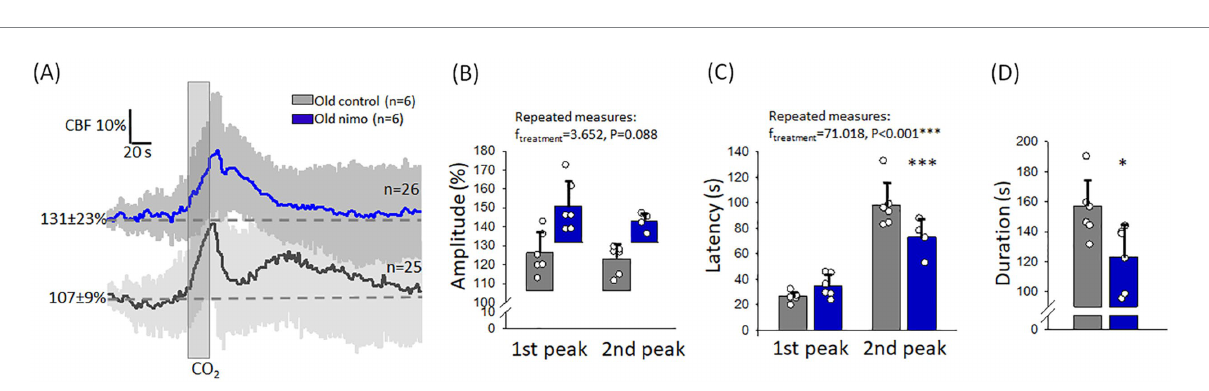
FIGURE 6 The impact of nimodipine treatment on the hyperemic response to hypercapnia in old animals. (A) Mean traces (±stdev) of the CBF response to hypercapnia in the Old control and nimodipine-treated Old nimo groups. (B) The amplitude of hyperemia. Note that the bars showing the relative amplitude are positioned on the CBF value preceding hypercapnia, to reflect the absolute amplitude of the CBF response. (C) The latency of the peak of hyperemia with respect to the onset of hypercapnia. (D) The duration of hyperemia. In B-D , data are given as mean ± stdev. The normal distribution of data was evaluated with a Shapiro–Wilk test ( B : p = 0.124-failed, C : p = 0.125, D : p = 0.999). In B-C , RM ANOVA was used, followed by a Holm Sidak post hoc test. In D , one-way ANOVA was applied, followed by a Holm Sidak post hoc test. Levels of significance are labeled as p < 0.05*, p < 0.001***, vs. Old